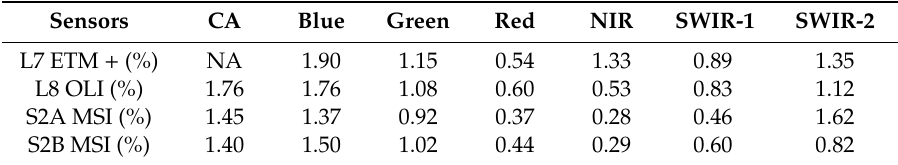
Table 8. Libya 1 random error (precision) between measured and simulated values.